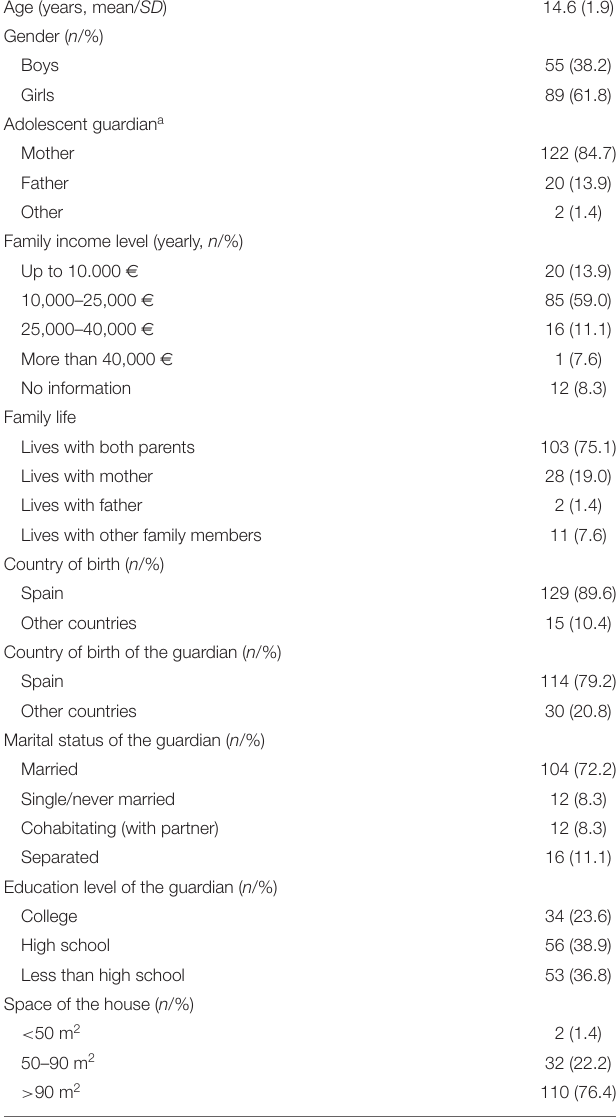
TABLE 1 | Sociodemographic characteristics of the sample ( N =